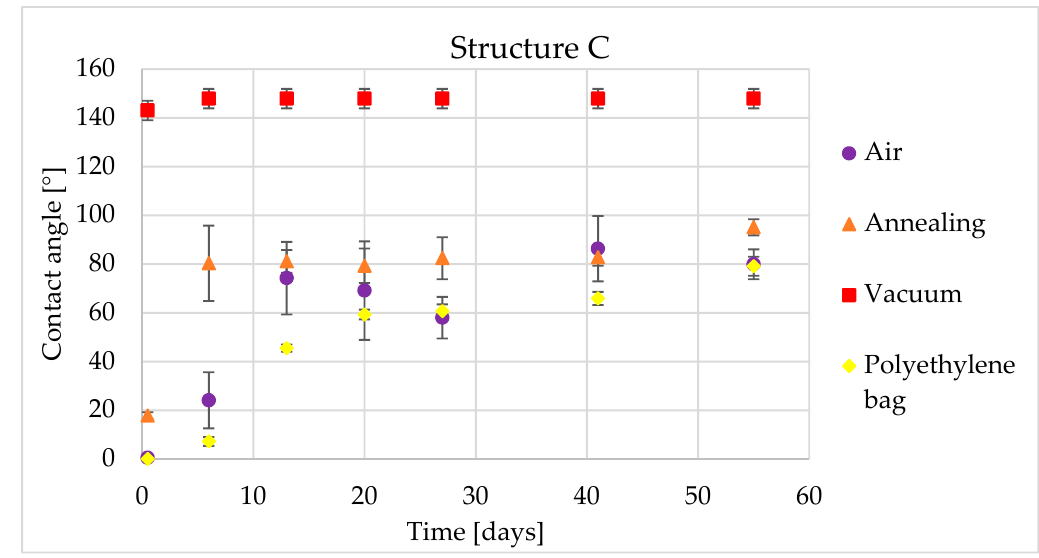
Figure 7. Time dependency of static contact angle for structure C and four types of post-processing.